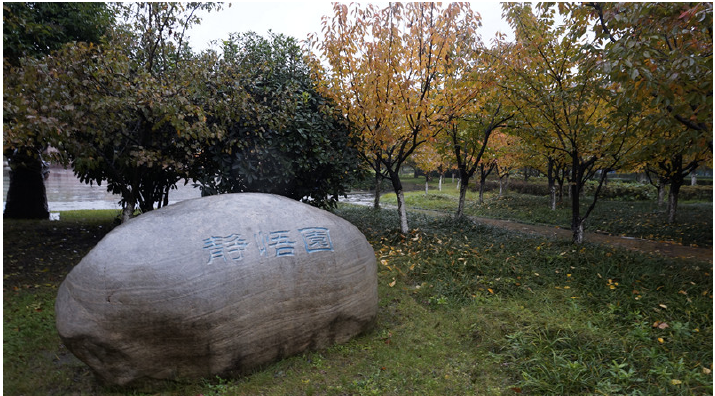
Figure 10. Jing-Wu Garden, inside the campus of Northwestern Polytechnical University, Xi’an, Shaanxi, China, where the navigation of the robot platform was